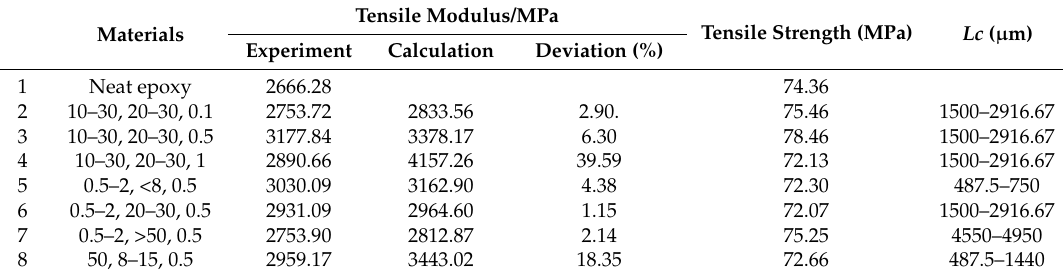
Table 5. Tensile Properties of multi-walled CNT (MWCNT)-reinforced